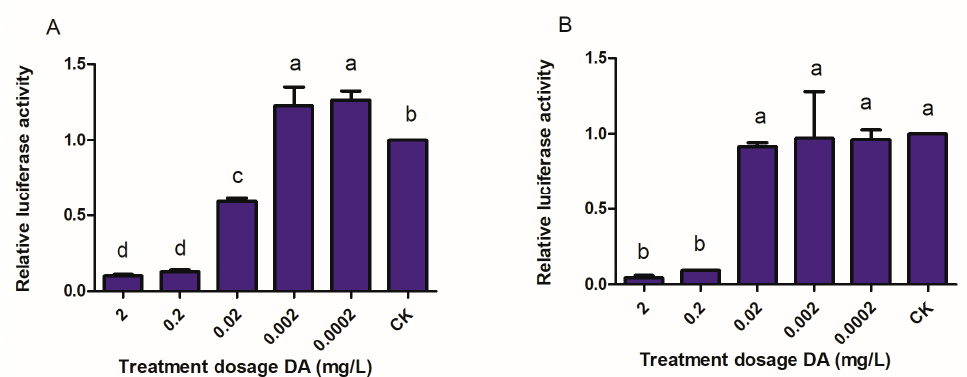
Figure 3. Effects of DA on the interactions of BmTMEM214–BmSEC13L ( A ) and BmSEC23–BmSEC13 ( B ) by I2H tests. The different letters on the columns indicate the significant difference ( p < 0.05) by Tukey’s HSD test. CK: DMSO-only treatment group.